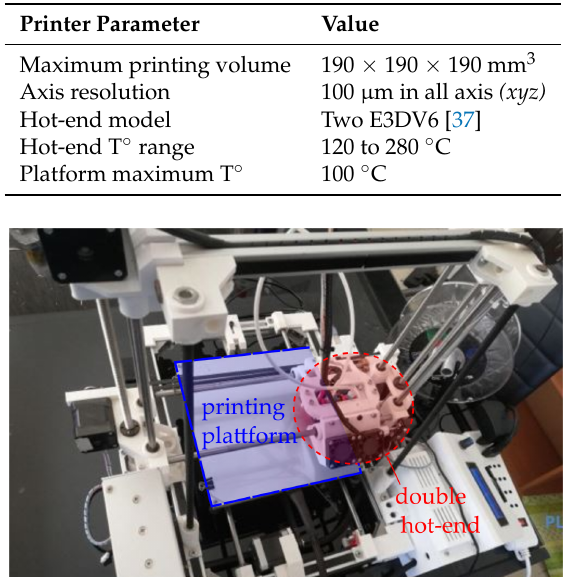
Table 1. Ocular3D EIE-custom 3D printer technical specifications